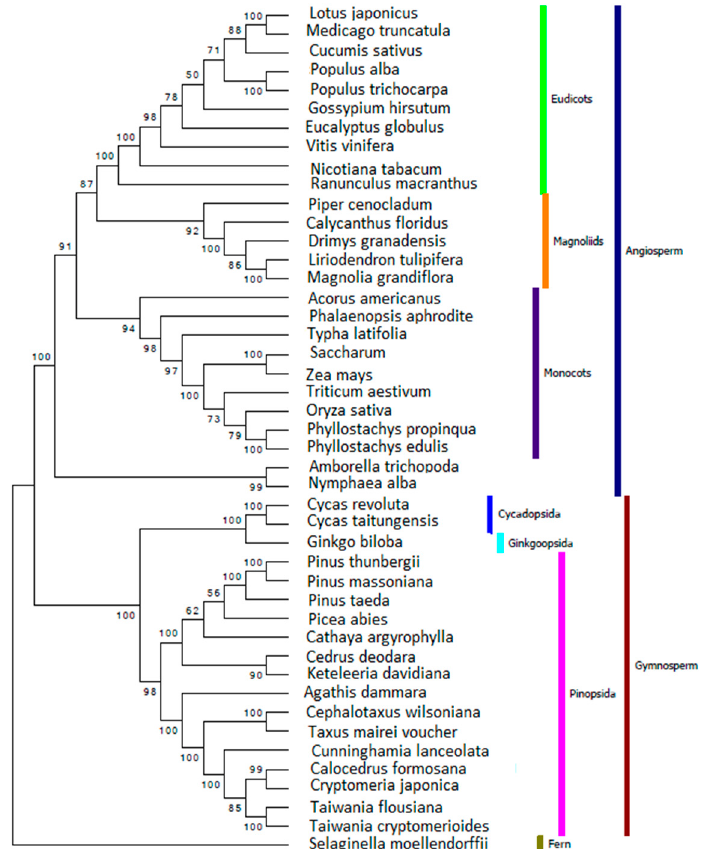
Figure 6. Phylogenetic analyses were performed based on the 65 protein-coding sequences in the 45-species matrix using the maximum likelihood (ML) methods implemented in MEGA5 [46] with the best models [47] calculated using the MEGA5 [46] embedded software “Find DNA/Protein Models” and rapid bootstrapping of 1000 replicates.